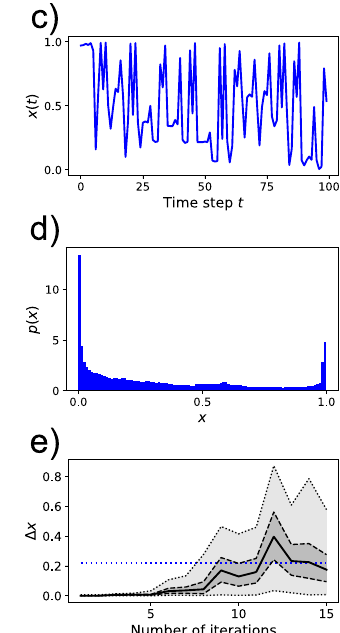
Fig. 9 Synthetic map. Constructing a synthetic chaotic map with a perfect distribution of permutation patterns. a Labelling of the six permutation patterns for d = 3. b Matrix representing the allowed transitions between permutation patterns and example of a possible periodic sequence of patterns. c Example of the time series that can be obtained from the previous sequence of permutation patterns. d Probability distribution of values for the resulting time series. e Sensitivity to initial conditions, calculated as the difference between two values of the resulting time series as a function of the number of iterations separating them. The solid black line indicates the median value, and dark and light grey bands, respectively, one and two standard deviations. The horizontal blue dotted line represents the expected value of the difference in a random time series with the same probability